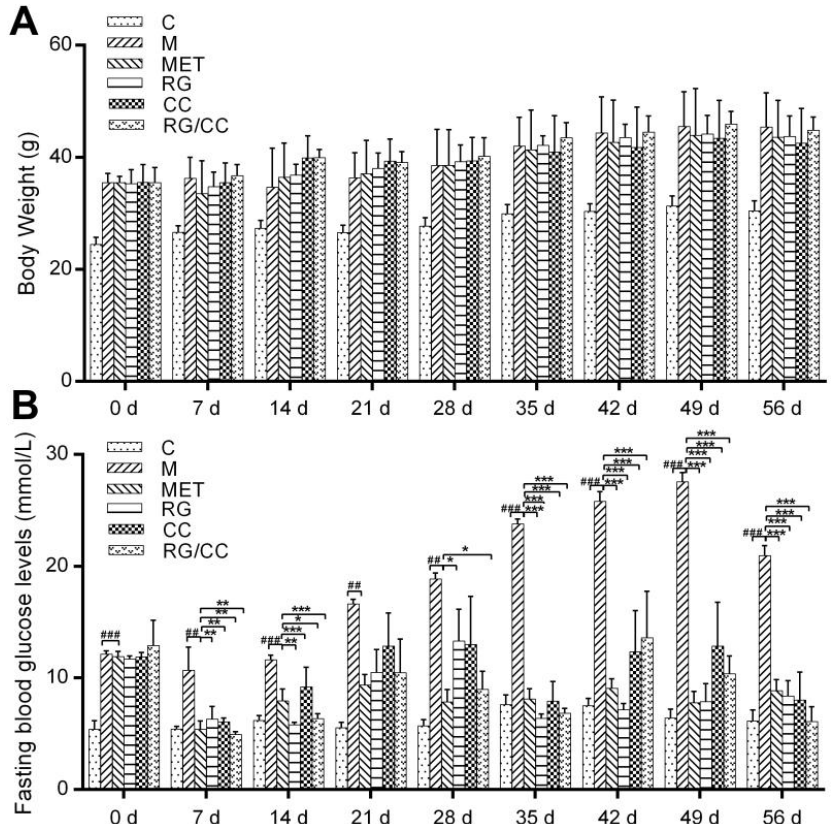
Figure 1. Changes of body weight ( A ) and fasting blood glucose levels ( B ) in different treatments of mice over 56 days of the experiment. ## p < 0.01, and ### p < 0.001 meant that the FBG value of the indicated group showed significant difference compared with the normal control group (C); * p < 0.05, ** p < 0.01, and *** p < 0.001 meant the FBG value of the indicated group was significantly different from the diabetic model control group (M). MET, RG and CC, RG/CC here and the below indicated diabetic mice groups administered separately with metformin (MET), decoctions of Rehmannia glutinosa (RG), Coptis chinensis (CC) and their combination